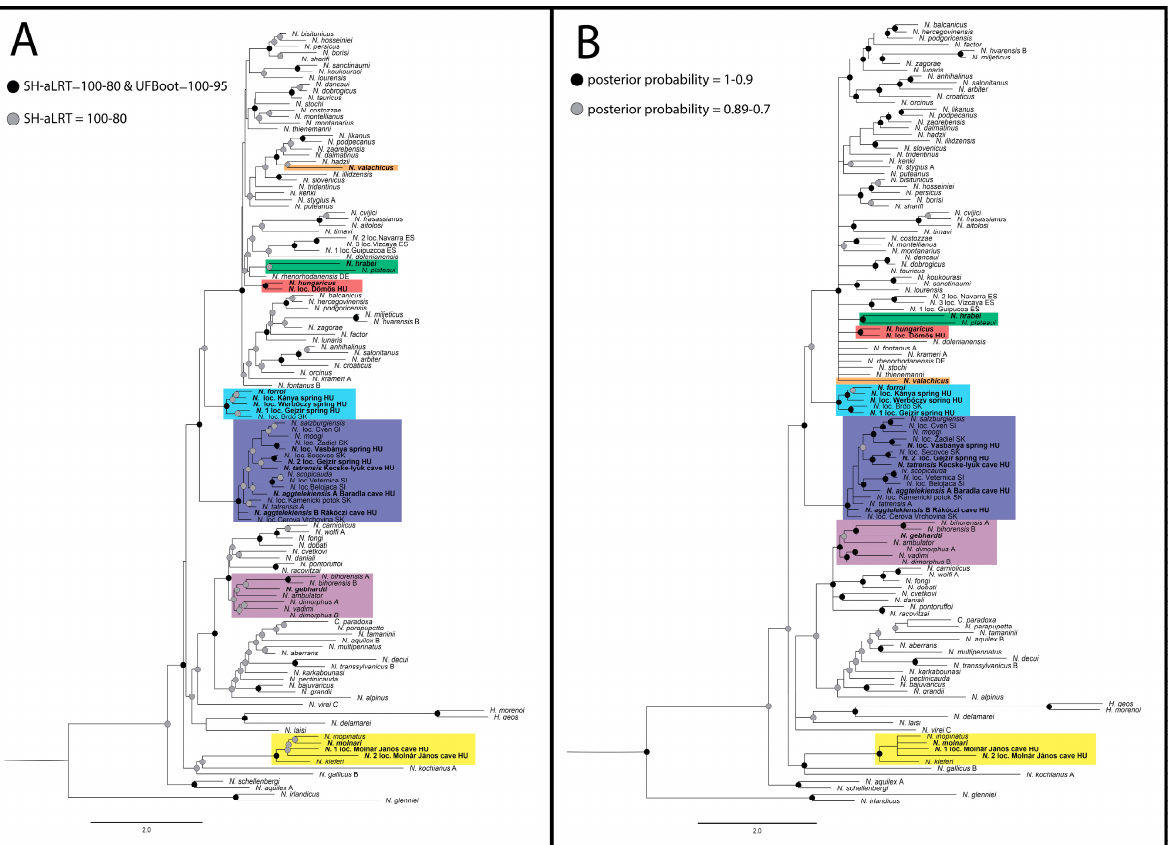
Figure 2. Phylogenetic relationships of the species in the genus Niphargus inferred from maximum likelihood ( A ) and Bayesian ( B ) approaches, including ultrafast bootstrap (UFBoot), Shimodaria– Hasewaga approximate likelihood ratio test (SH–aLRT) and Bayesian posterior probability support values. Outgroup species have been removed. The specimens from Hungary are in bold and the clades including specimens from Hungary are colour coded using the same colours as on Figures 1 and 3.